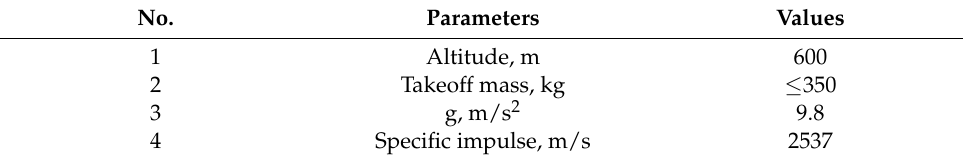
Figure 1. First flight scenario sketch. Table 1. Design input for the first scenario.